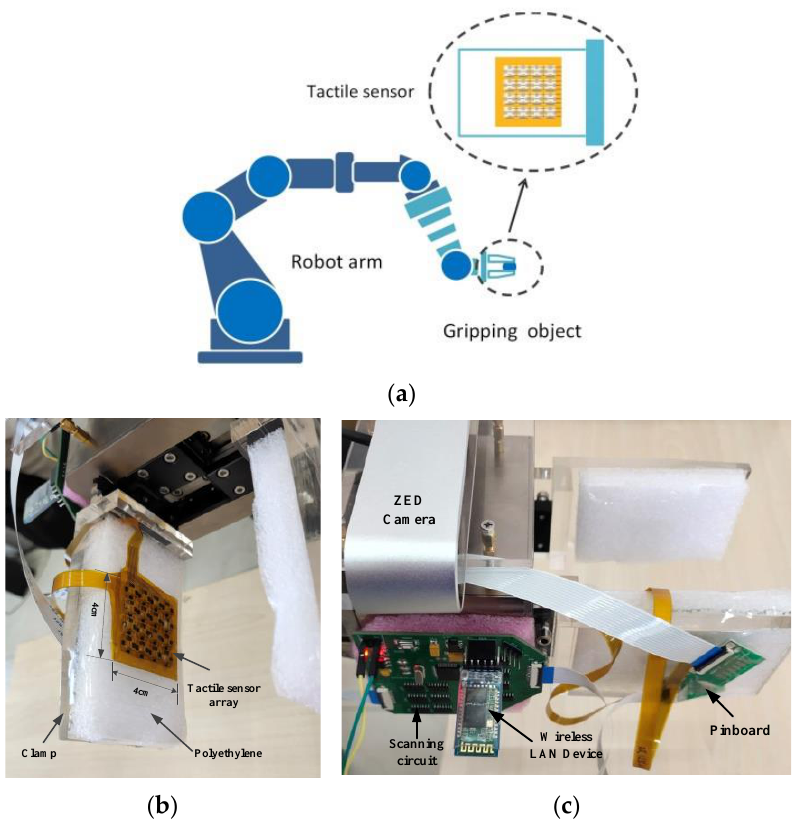
Figure 1. Robot with flexible tactile sensor array. ( a ) Schematic diagram of grasping operation with tactile sensor. ( b ) Instalation of tactile sensor array at the clamp of robot. ( c ) The assembly of tactile data collecting system.